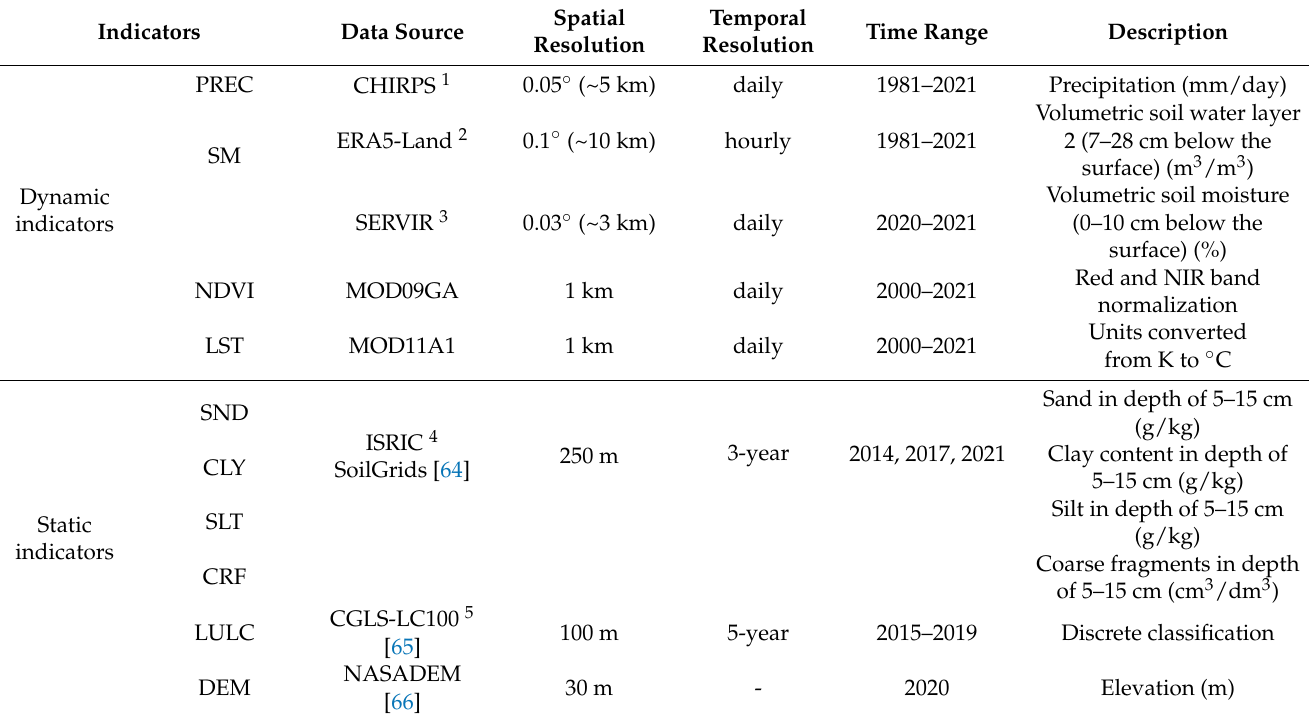
Table 1. Multiple indicators and multisource